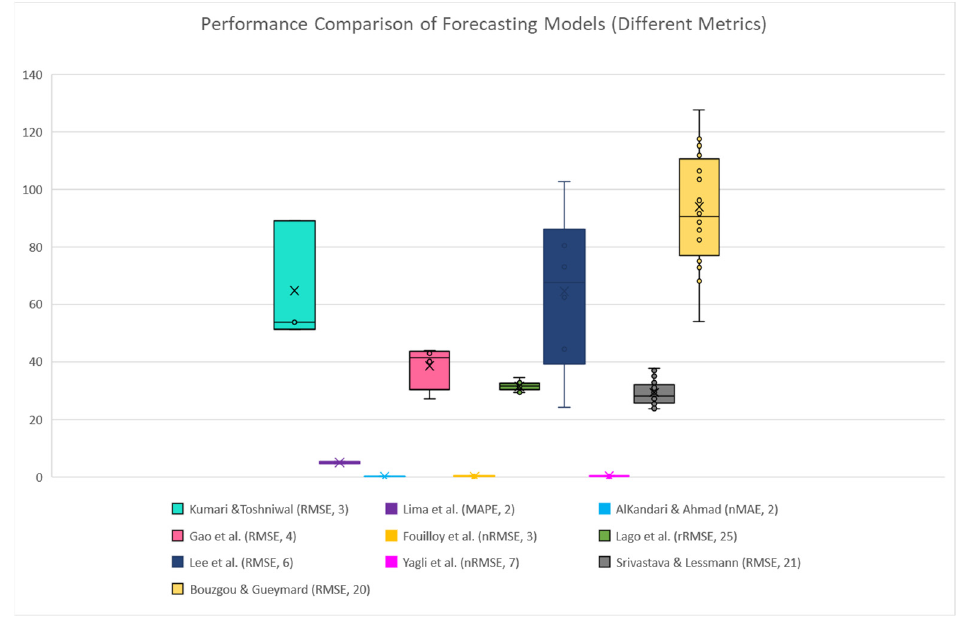
Figure 1. Performance comparison of solar forecasting models (different performance metrics).